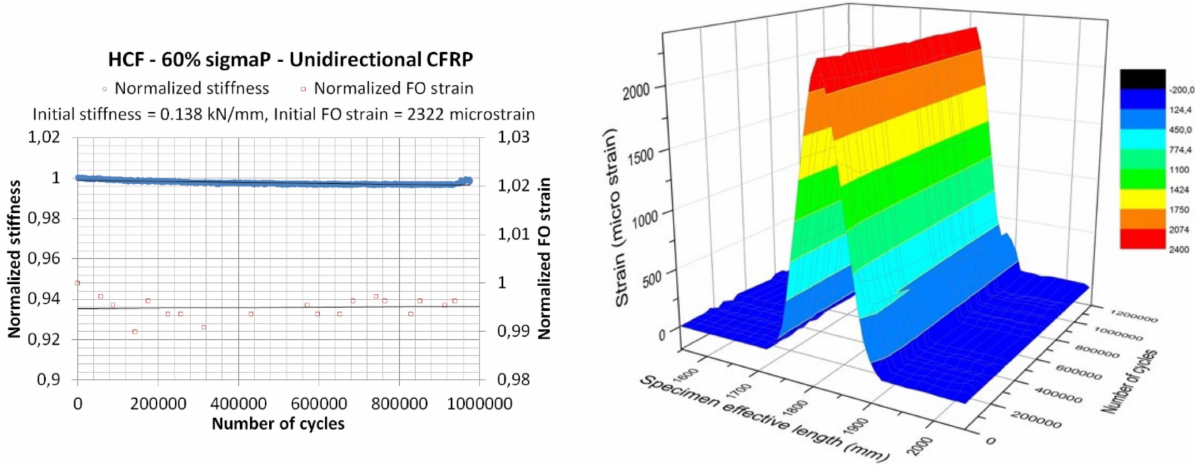
Figure 22. HNCF test curve (0.6 σ p) of UD smart specimen and corresponding 3-D HNCF test curve.